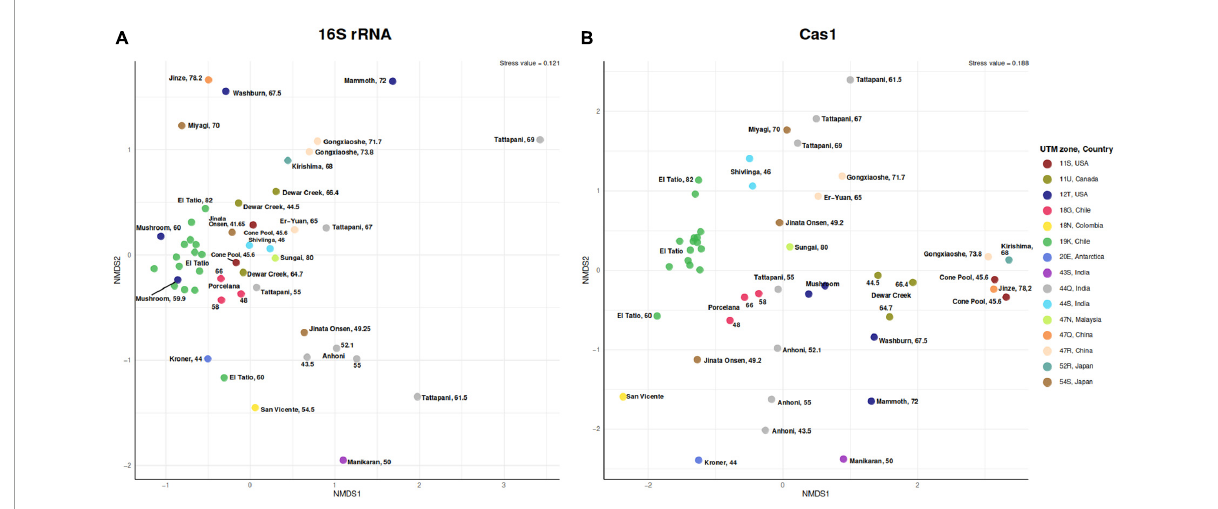
FIGURE3 Non-metric multidimensional scaling of beta diversity (Bray–Curtis index) showing dissimilarity of the (A) 16S rRNA gene and (B) Cas1 genes from 48 metagenomes. Points are colored according to Universal Transverse Mercator coordinates (UTM) and country (right